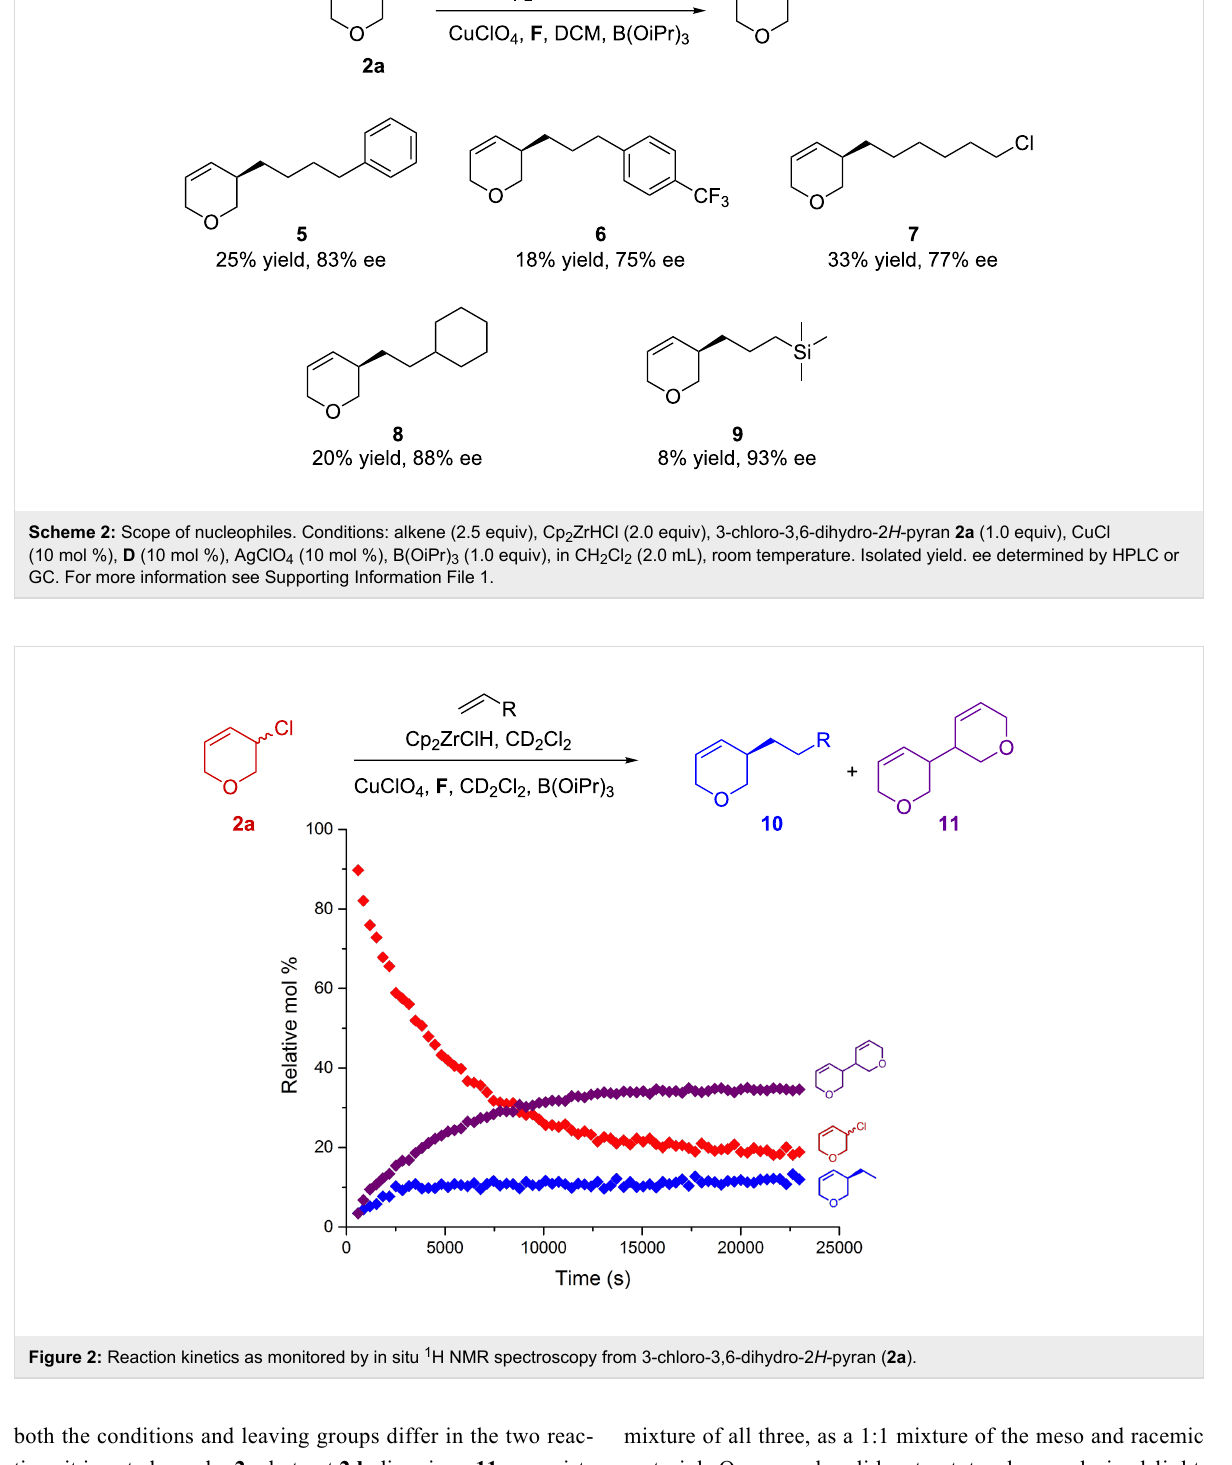
mixture of all three, as a 1:1 mixture of the meso and racemic material. Our samples did not rotate plane polarized light, emphasizing the racemic nature of the sample and suggesting that 11 is formed in a completely non-selective